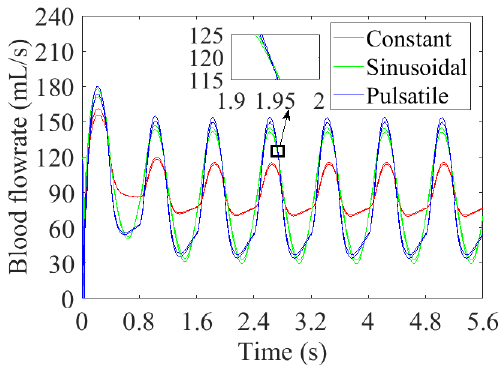
Figure 10. Blood flow rate variation characteristics with time; the curve in the frame indicates the di ff erence between the blood pump flow rate and the blood flow rate in the aorta. difference between the blood pump flow rate and the blood flow rate in the aorta.